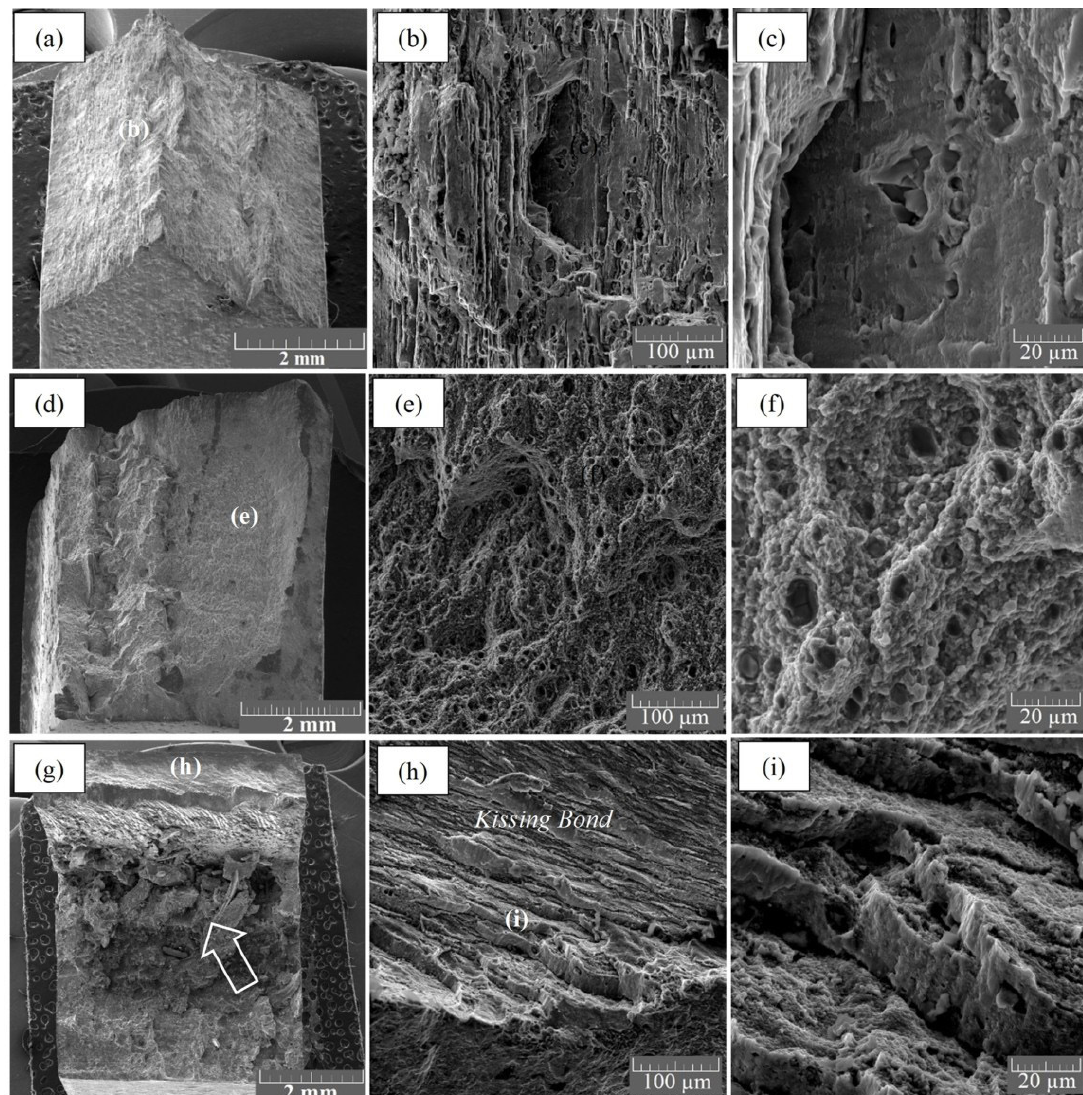
Figure 13. Fractographic analysis via SEM: (a) BM 30x, (b) BM 500x, (c) BM 2000x, (d) welded joint 1 in 30x, (e) welded joint 1 in 500x, (f) welded joint 1 in 2000x, (g) welded joint 4 in 30x, (h) welded joint 4 in 500x, (i) welded joint 4 in